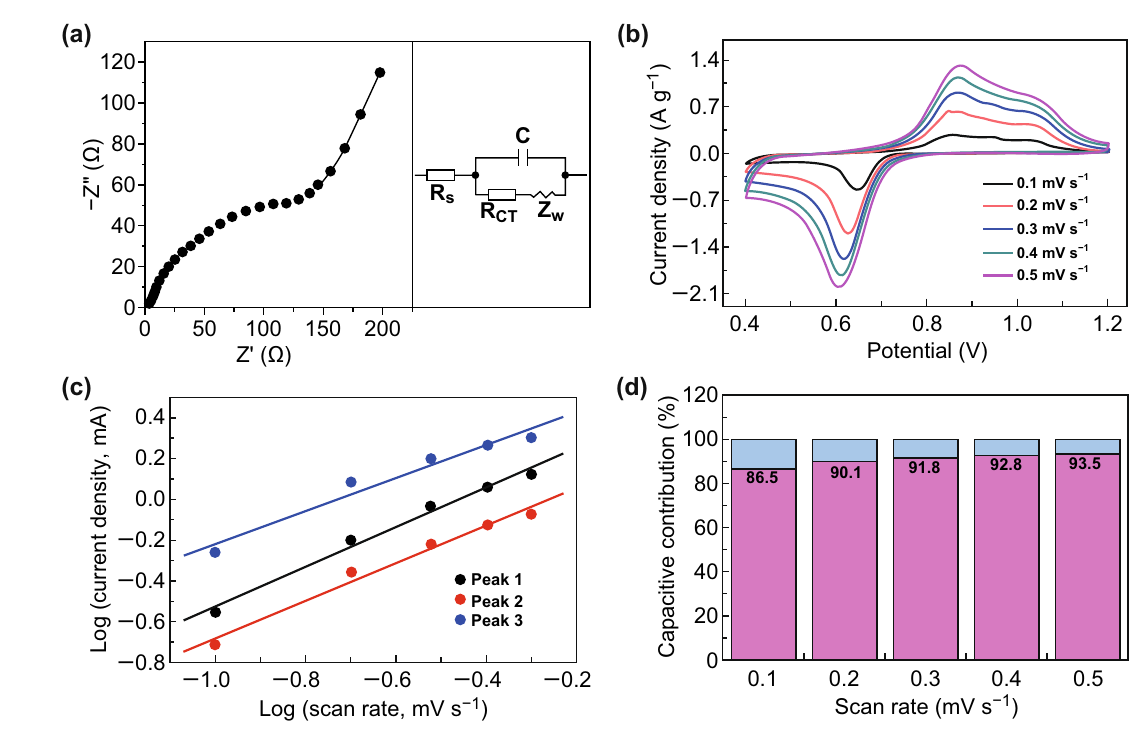
Fig. 3 a Electrochemical impedance spectroscopy (EIS). b CV curves at different scan rates. c The corresponding plots of log (peak current) versus log (scan rate) at the redox peaks. d The calculated capacitive